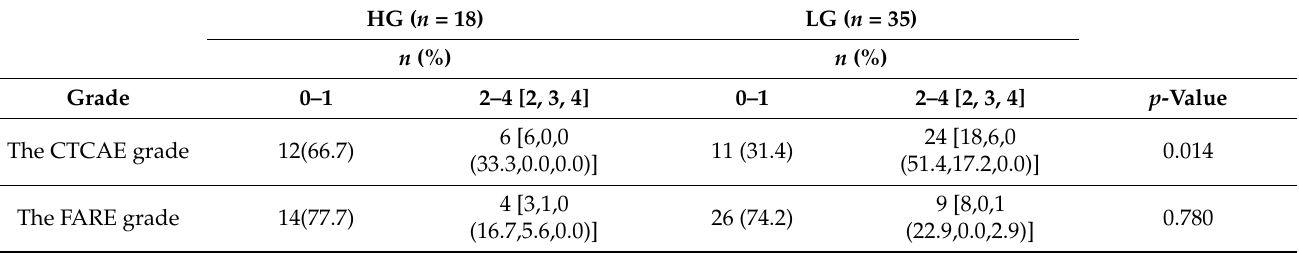
Table 5. Evaluation of radiation esophagitis at the time of 58 Gy irradiation with ENI plus proton beam therapy ( n =